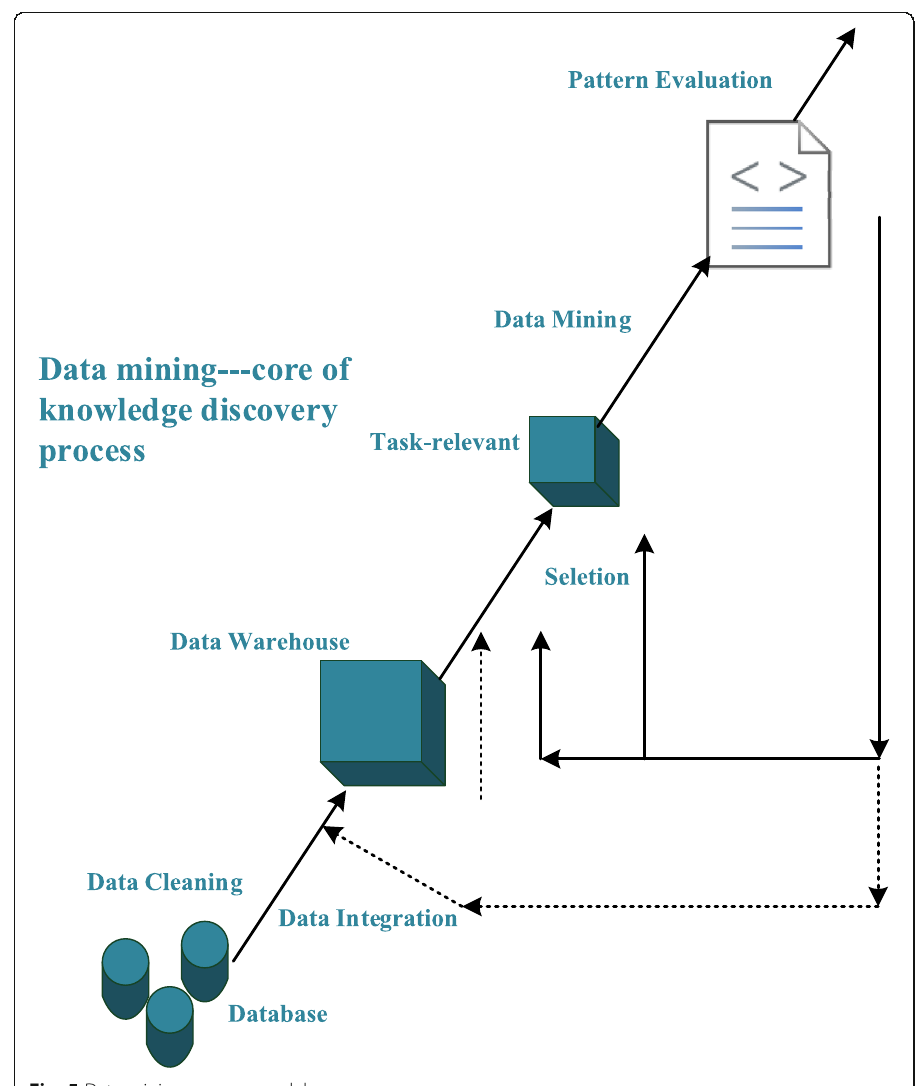
Fig. 5 Data mining process